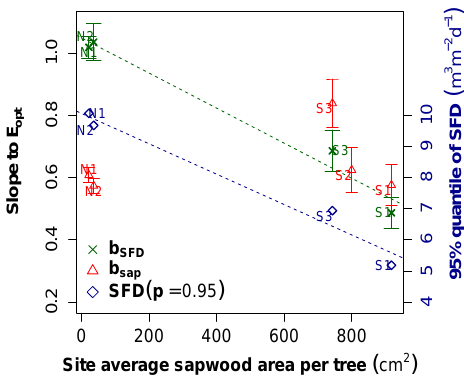
Figure 6. Sensitivity to E opt as a function of the site-average sap- wood area per tree computed by A s /n tree . On the left y axis: sensi- tivity of site-average sap flux density b SFD (green crosses; see also Table 3) and the sensitivity of the upscaled transpiration estimate b sap (red triangles). The vertical bars show the standard deviation of the sensitivity estimates tabulated in Tables 2 and 3. Right y axis: 95% quantile of daily SFD maxima per site to estimate a robust maximum SFD. The dashed lines show linear regression model